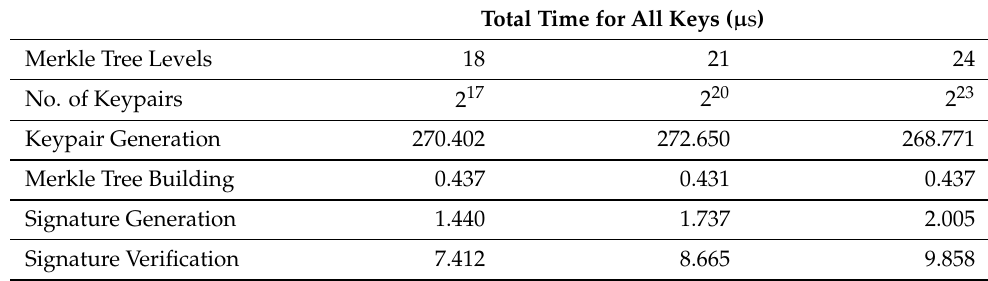
Table 2. Average time required to run an individual algorithm in the protocol (per